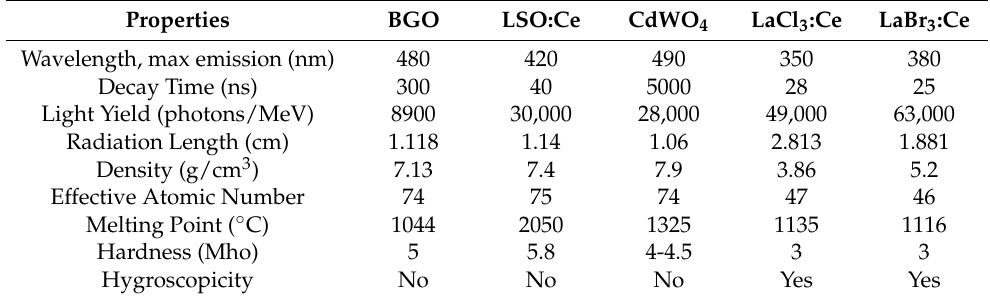
Table 1. BGO, LSO, CdW0 4 , LaCl 3 :Ce and LaBr 3 :Ce crystal properties